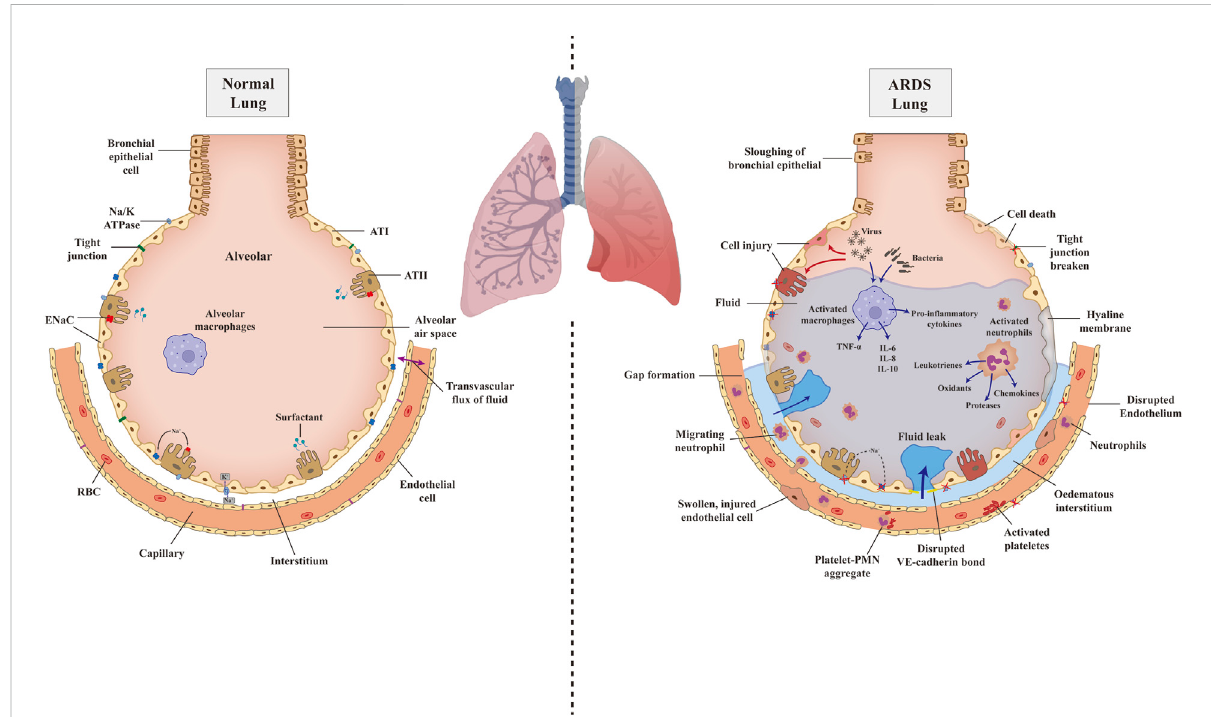
FIGURE 1 The pathophysiology of normal lung and ARDSinjured lung.Schematicillustrationdepicting pathophysiology of thenormal lung (left) progress toARDSlung(right)duetotheattackofpathogensandillustratingthedetailsofrelatedmechanisms.AT,alveolartypecell;ENaC,epitheliumsodium channel; RBC, red blood cell; TNF- α , tumor necrosis factor- α ; IL, interlukin; PMN, polymorphonuclear cells; VE-cadherin, vascular endothelial